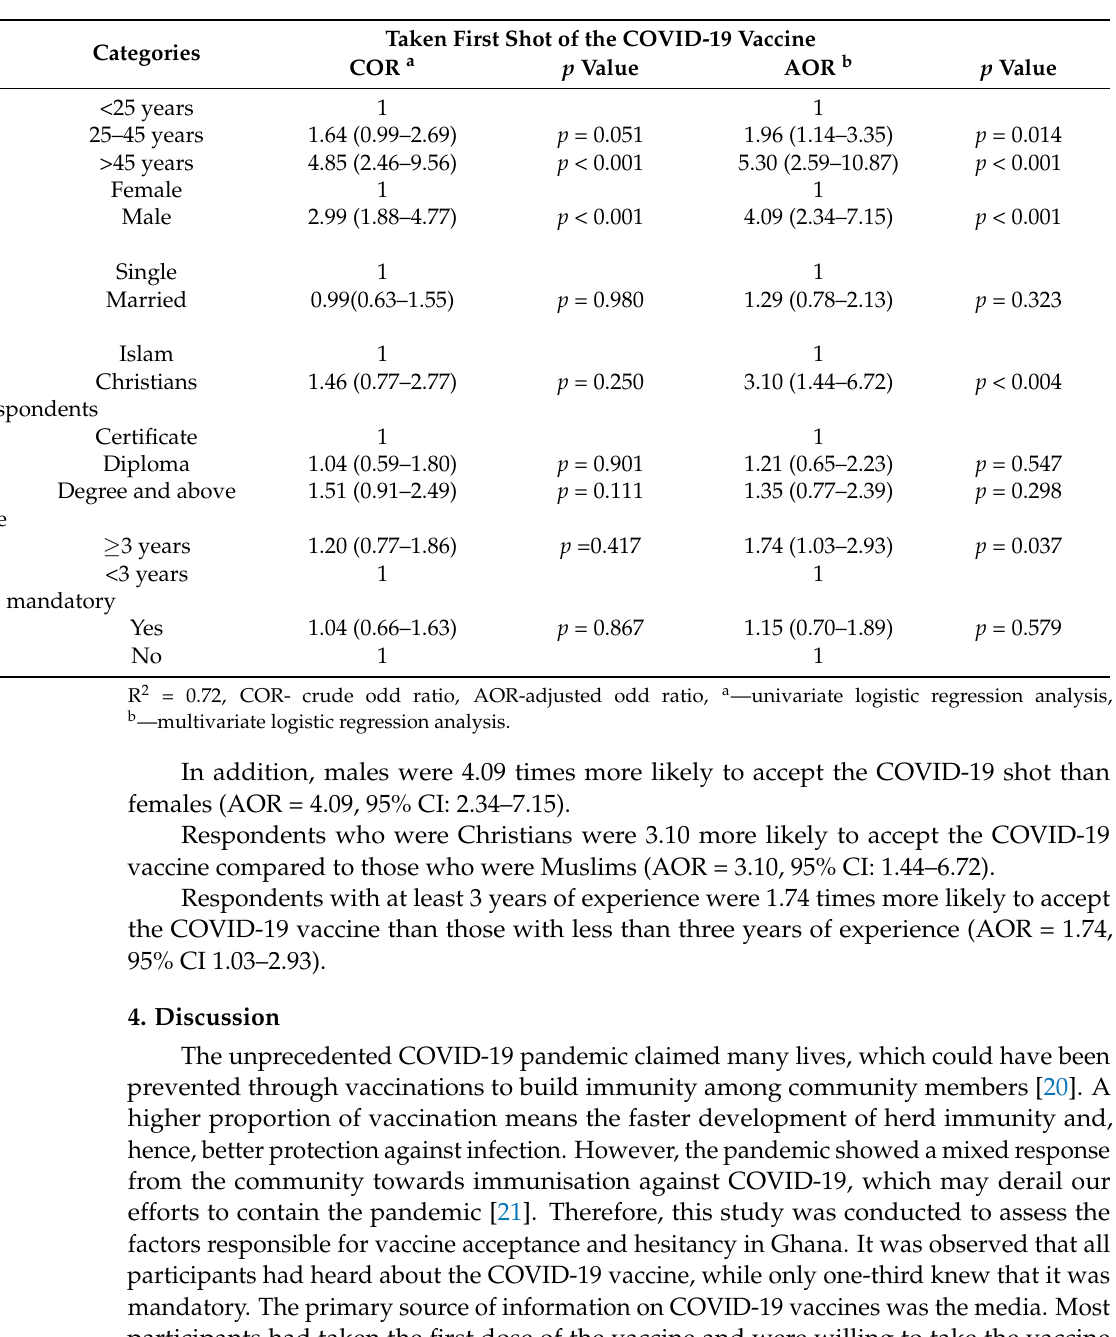
Table 4. Factors influencing the acceptance of the first shot of